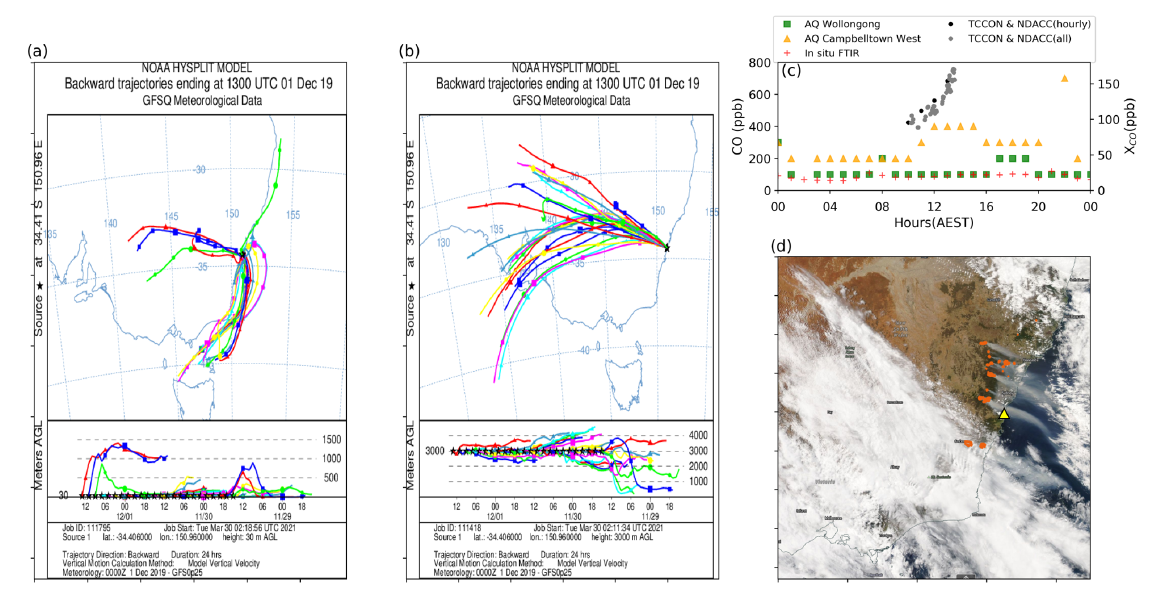
Figure 8. 1 December 2019: 24 h NOAA HYSPLIT back trajectories (UTC) at ( a ) 30 m and ( b ) 3000 m; ( c ) Hourly averaged surface in situ CO measurements at Wollongong air quality monitoring site (green squares), Campbelltown West air quality monitoring site (yellow triangles) and Wollongong in situ FTIR (red crosses). Black and grey dots show hourly averaged column CO measurements (TCCON & NDACC) and all native temporal resolution column measurements, respectively (in AEST: UTC + 10 h). ( d ) MODIS hotspot image with thermal anomalies [68] (zoomed in for southeast Australia). The UOW measurement site is marked with a yellow